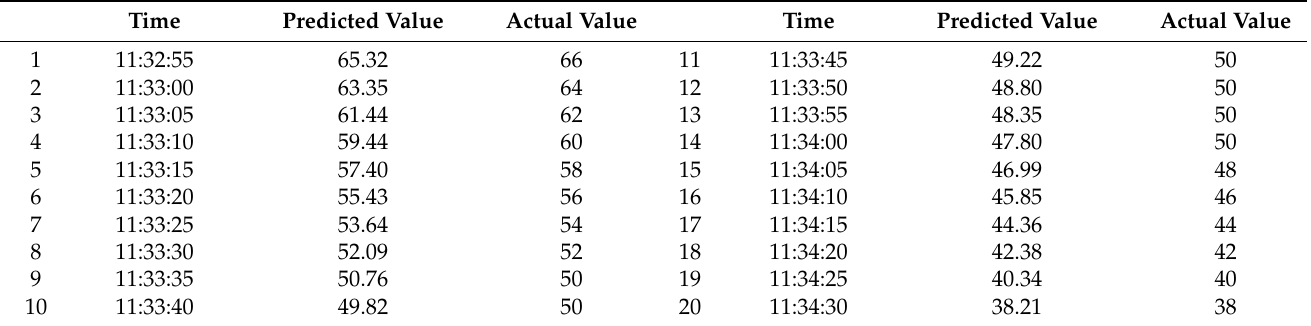
Table 1. Partial comparison results of actual and predicted values of slurry level in the mixing